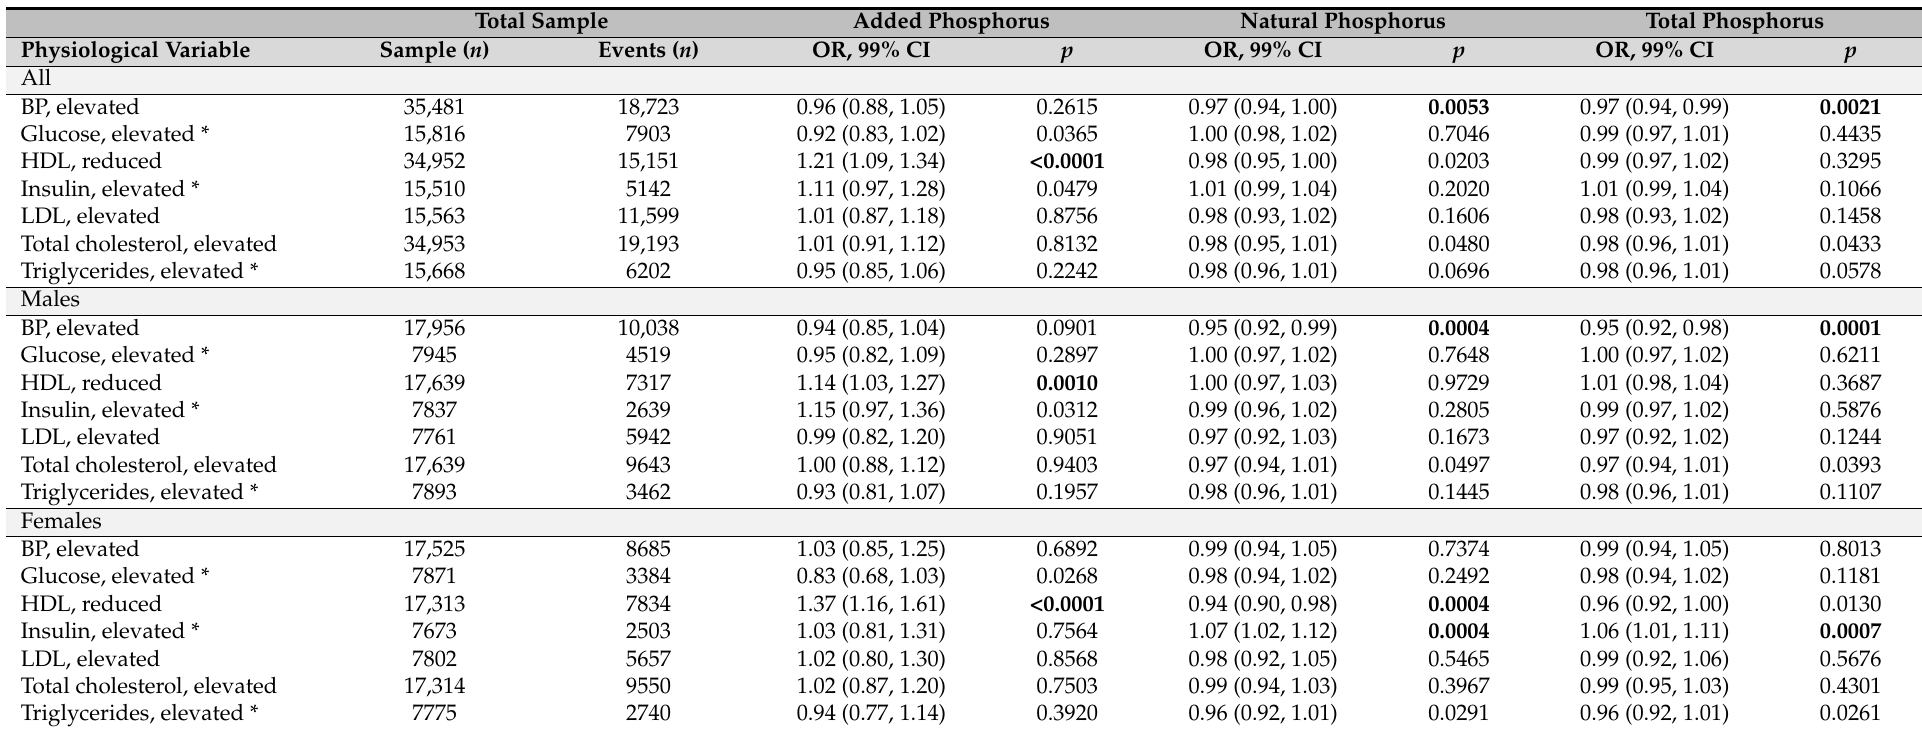
Table 2. Odds Ratios for Phosphorus Intake and Physiological Variables 1,2 in adults 19+ years of age and older, NHANES